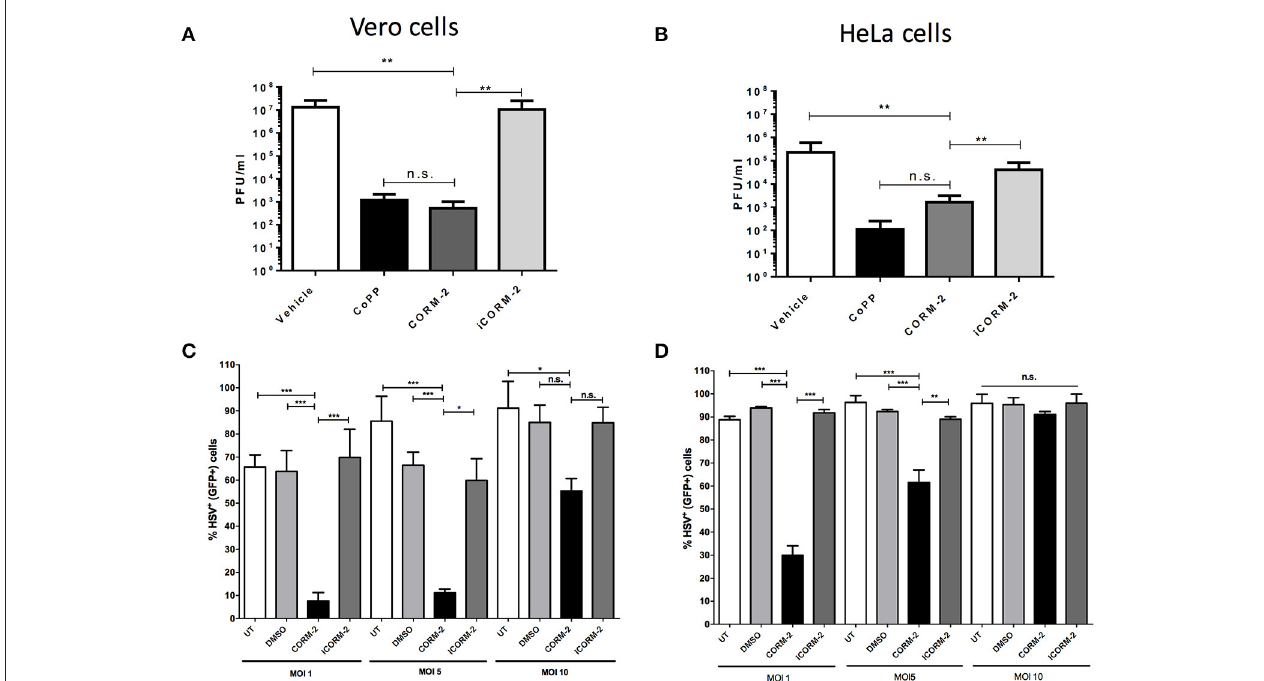
FIGURE 5 | Treatment with a carbon monoxide-releasing molecule recapitulates the antiviral effects of CoPP after HSV infection. Quantification of plaque forming units (PFU) after HSV-2 titration over (A) . Vero and (B) . HeLa cells treated with CORM-2 and inactivated CORM-2 (iCORM2). Virus-encoded GFP fluorescence (non-structural GFP reporter) determined by flow cytometry in (C) . Vero and (D) . HeLa cells infected with HSV at different MOIs at 20h post-infection. Data are means ± SEM of three independent experiments. One-way ANOVA, and Tukey’s multiple comparison test were used for statistical analyses (* p < 0.05, ** p < 0.01, *** p <